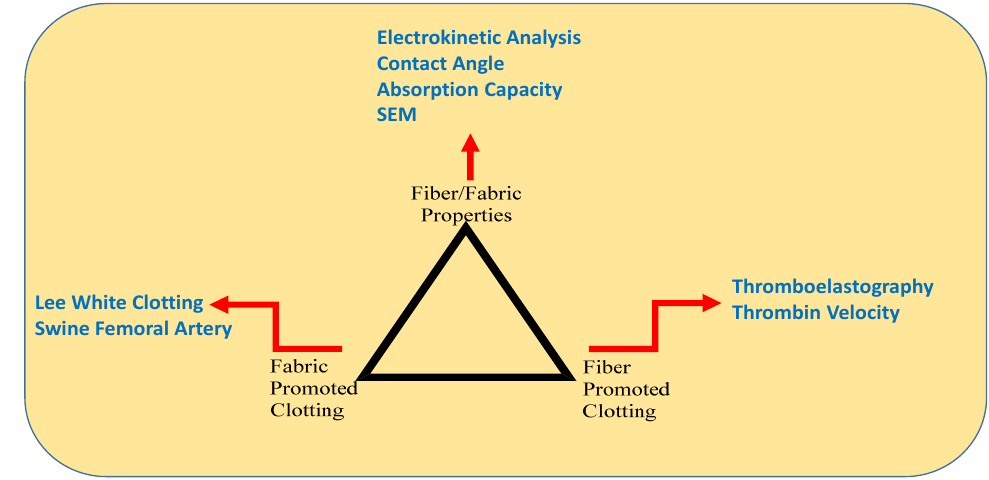
Figure 2. A diagram of the three-point approach taken, where fiber promoted clotting (as measured by thromboelastography (TEG)) were correlated with fabric and fiber surface polarity and absorption properties, as measured with electrokinetic profiles and absorption capacity, related to fabric promoted clotting, as measured with the Lee White clotting and thrombin assays.